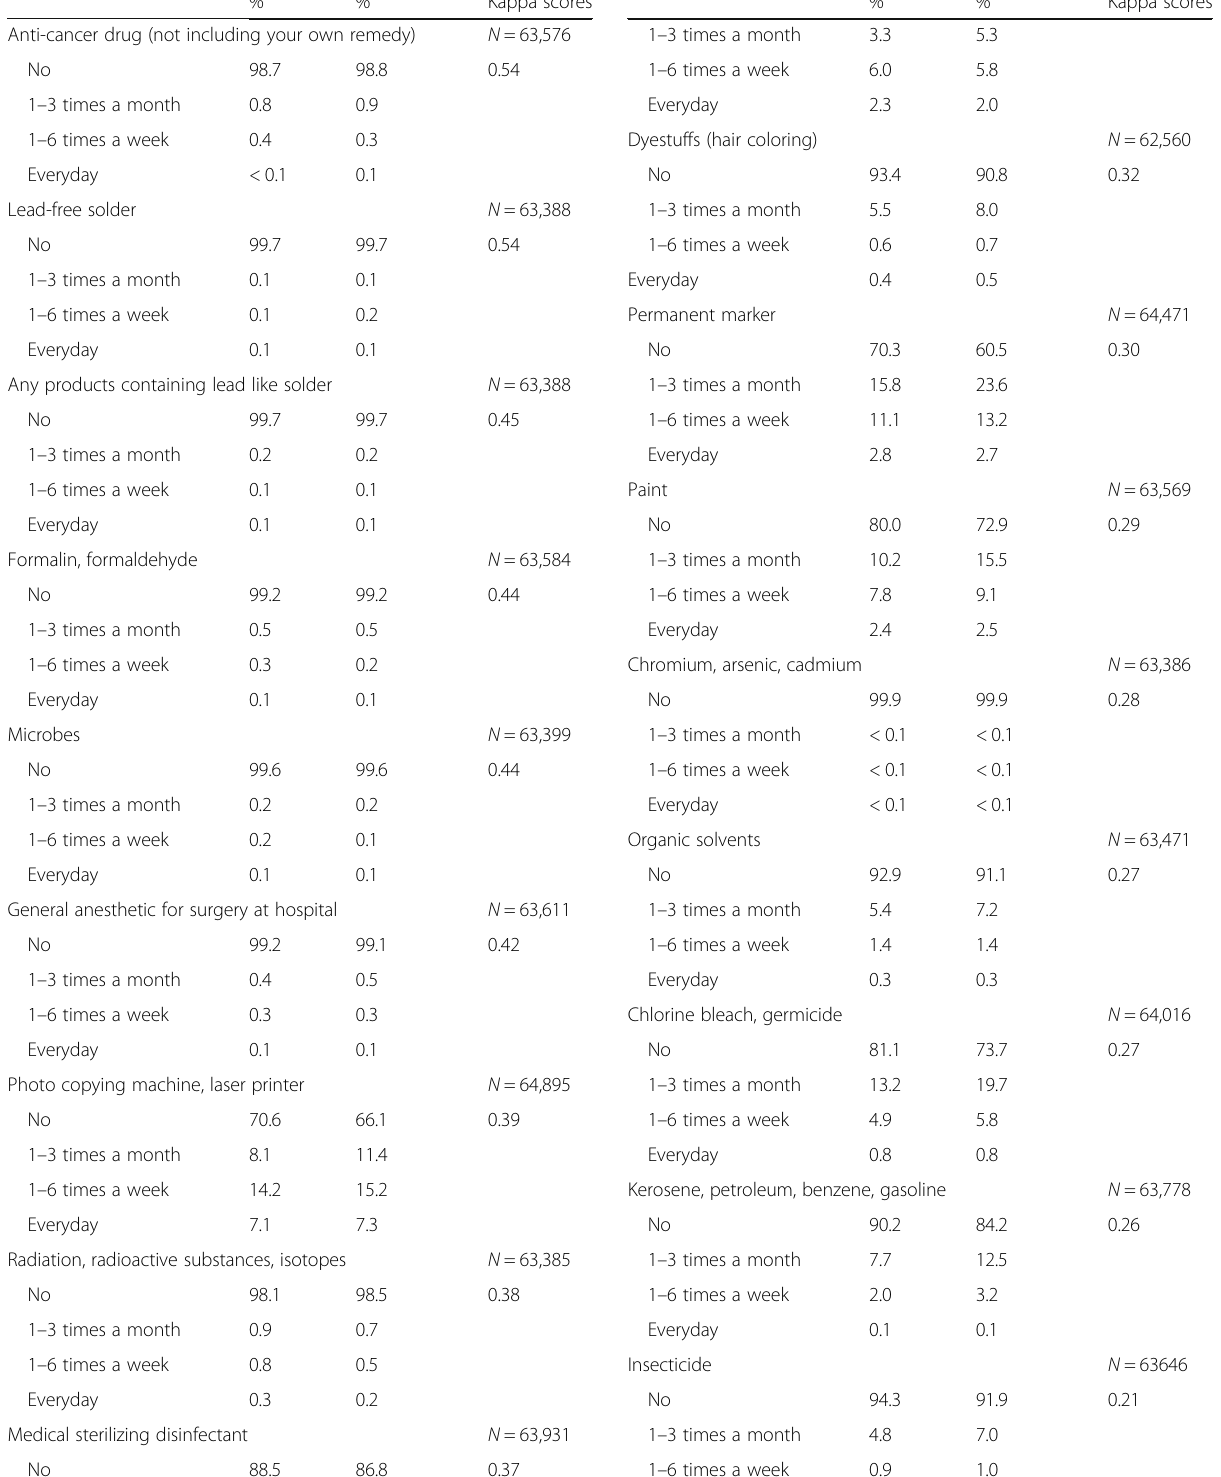
Table 3 Frequency of the occupational use of chemicals for more than half a day during pregnancy (MT1 and MT2